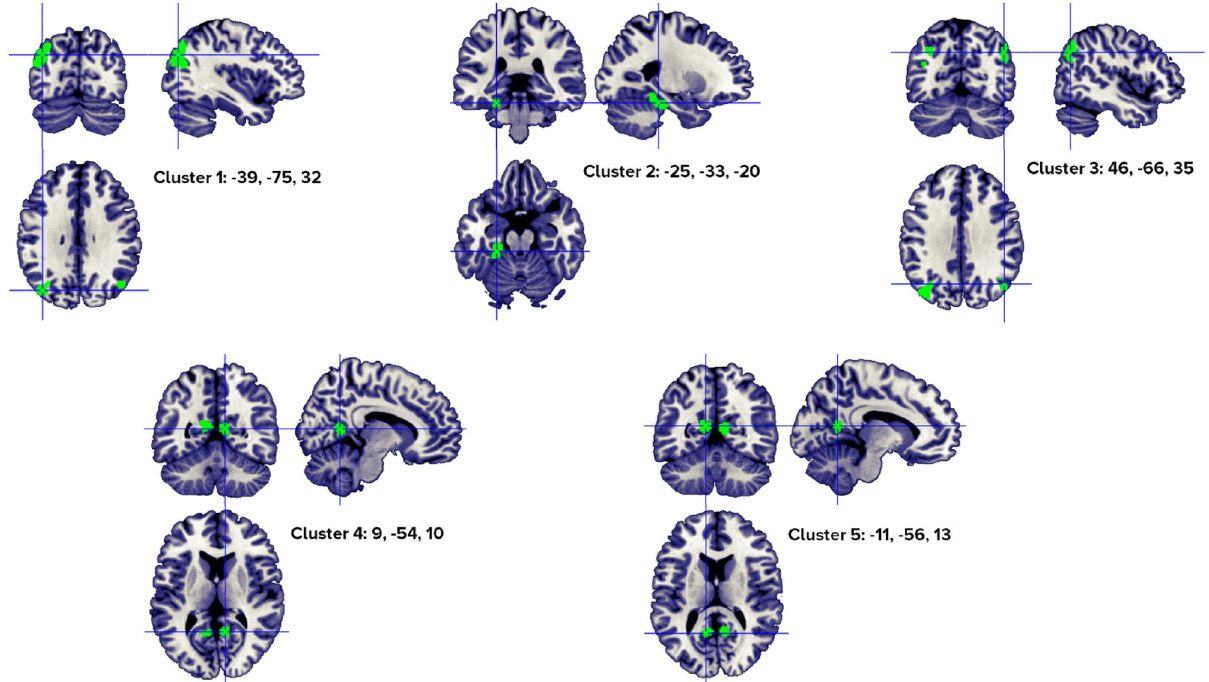
Figure 4. Clusters activated by the concrete > abstract words—visual stimuli—contrast. The crosses are centered in the areas correspond to stereotactic coordinates reported in Table 4. The images are presented in neurological